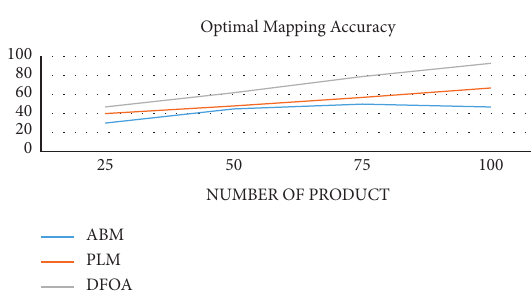
Figure 4: The accuracy of the optimal mapping.